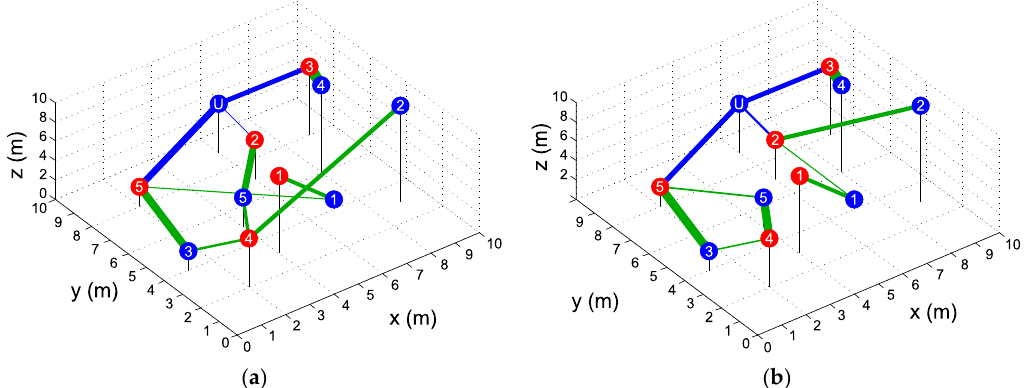
Figure 4. ( a ) 3D layout representation of the optimal HEN configuration of example 1b, the chosen line thickness is proportional to the corresponding heat exchanger heat load; and ( b ) 3D layout representation of the alternative HEN configuration of example 1b, the chosen line thickness is proportional to the corresponding heat exchanger heat load.